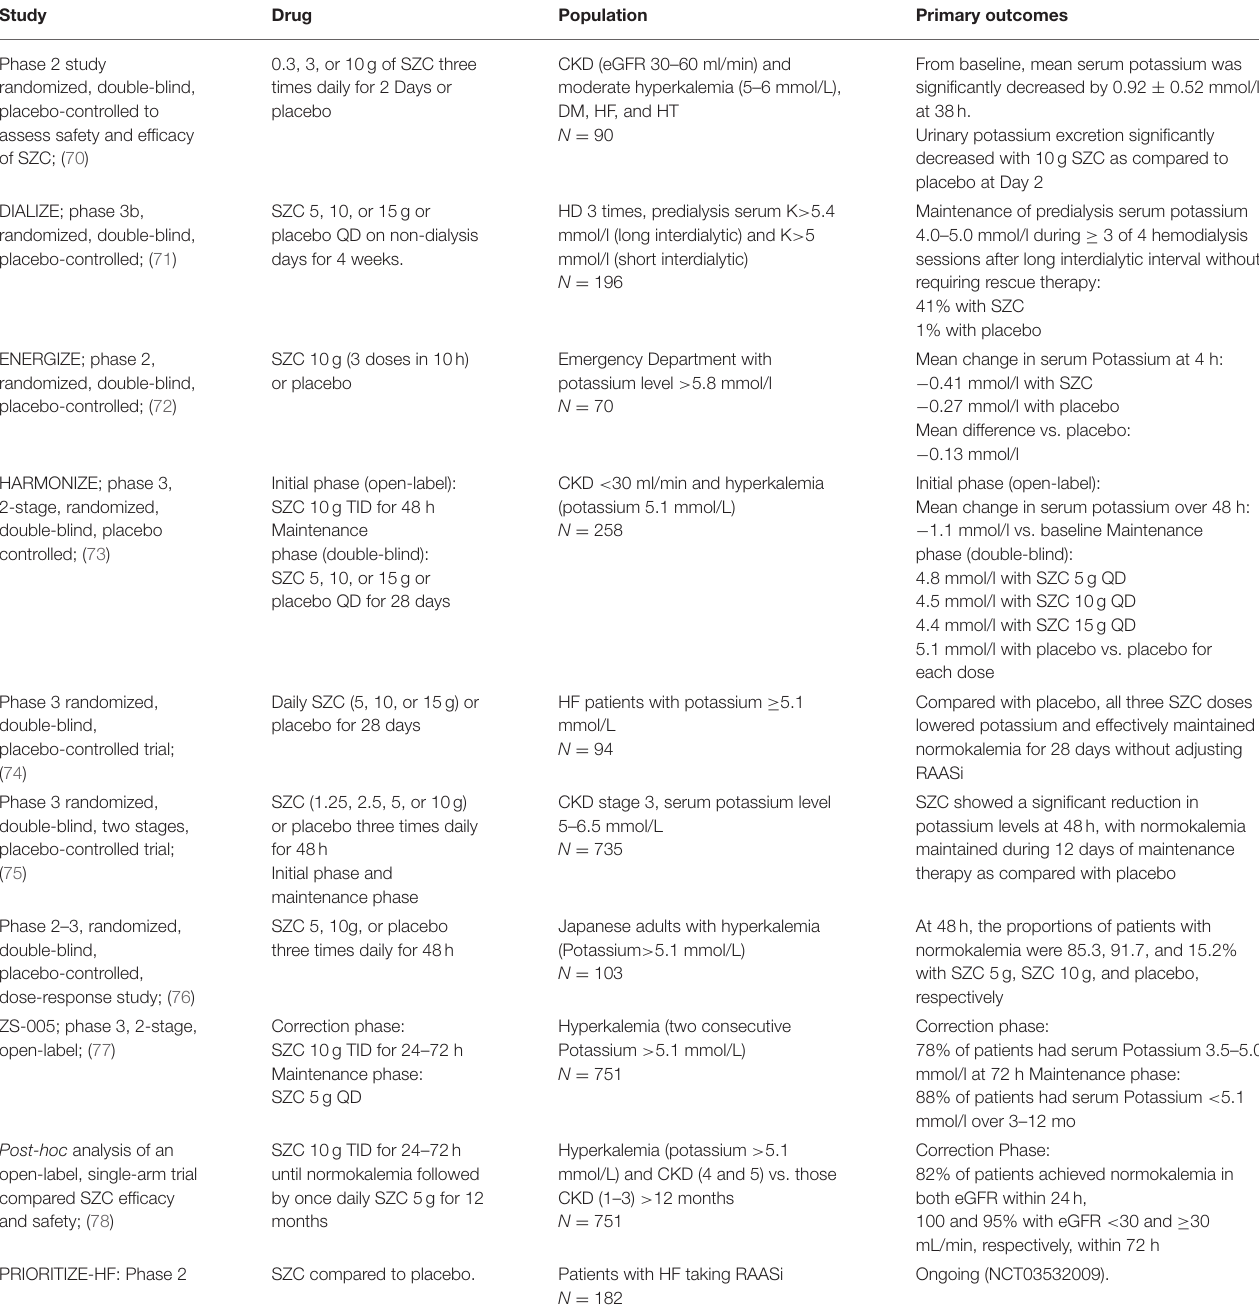
TABLE 4 | Clinical studies of SZC (54). Study Drug Population Primary outcomes Phase 2 study randomized,